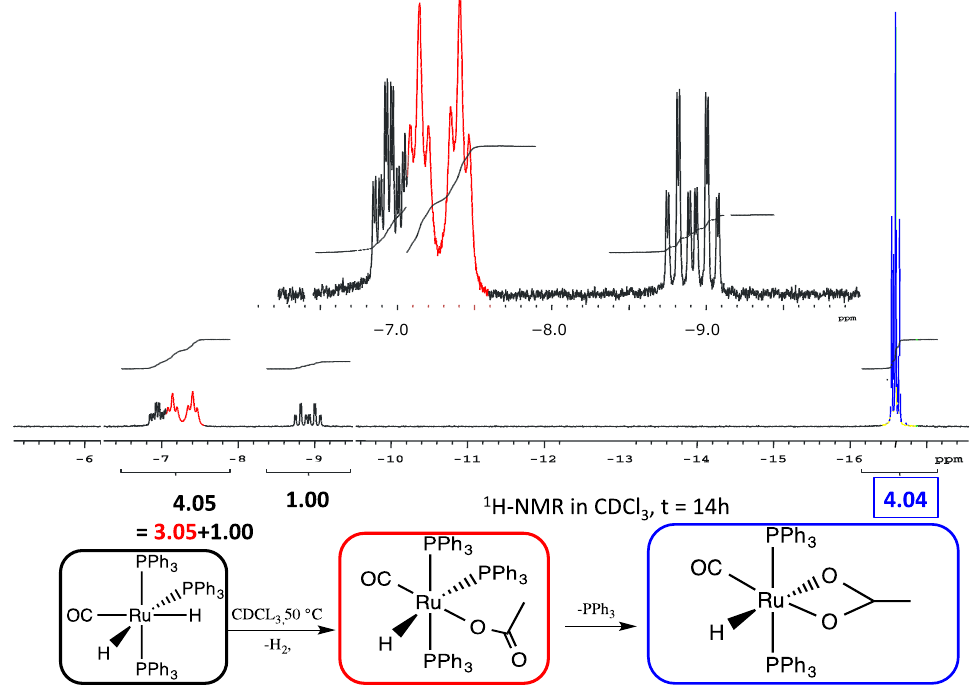
Figure 3. 1 H NMR (nuclear magnetic resonance) spectrum of the two 3a, 3b mer - κ 1 (O)THAc-[Ru(CO)H (PPh 3 ) 3 ] rotamers evidences two doublets of triplets (dt, − 6.12 ppm; − 7.27ppm, in red) and a triplet for the chelate trans (P,P) - κ 2 (O,O)THAc- [Ru(CO)H(PPh 3 ) 2 ] 4 (t, − 17.01 ppm in